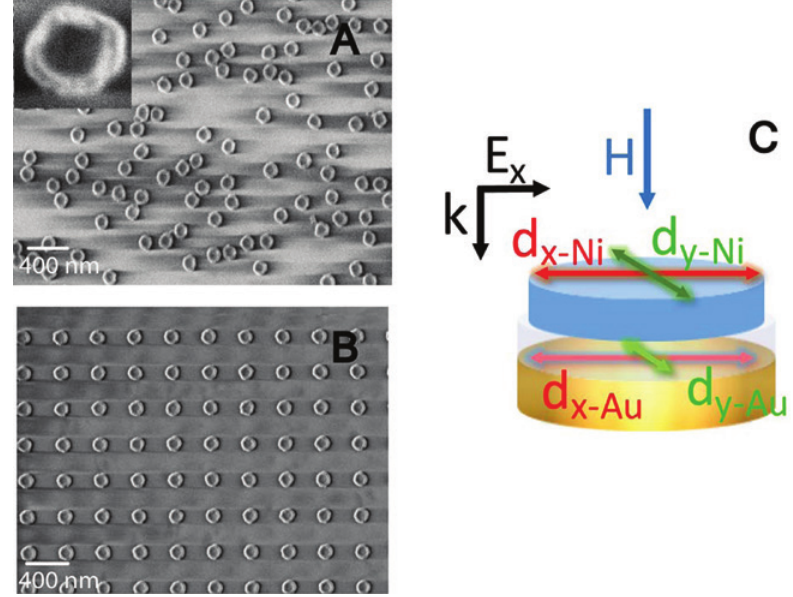
/Au dimers ( a = 400 nm). 2 ). Near-field coupling to this LSPR in Ni y-Ni